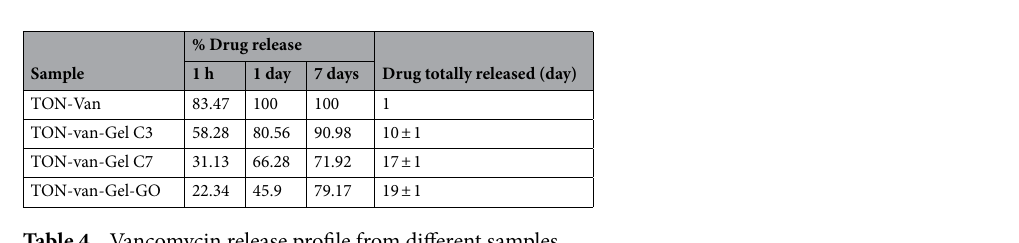
Figure 7. (a) Calibration curve of serial dilutions of Vancomycin in PBS, (b ) Vancomycin release profile from different layers of gelatin coating, (c) Vancomycin release profile from gelatin-GO coating and (d) concentration of released drug from TON-Gel-GO.